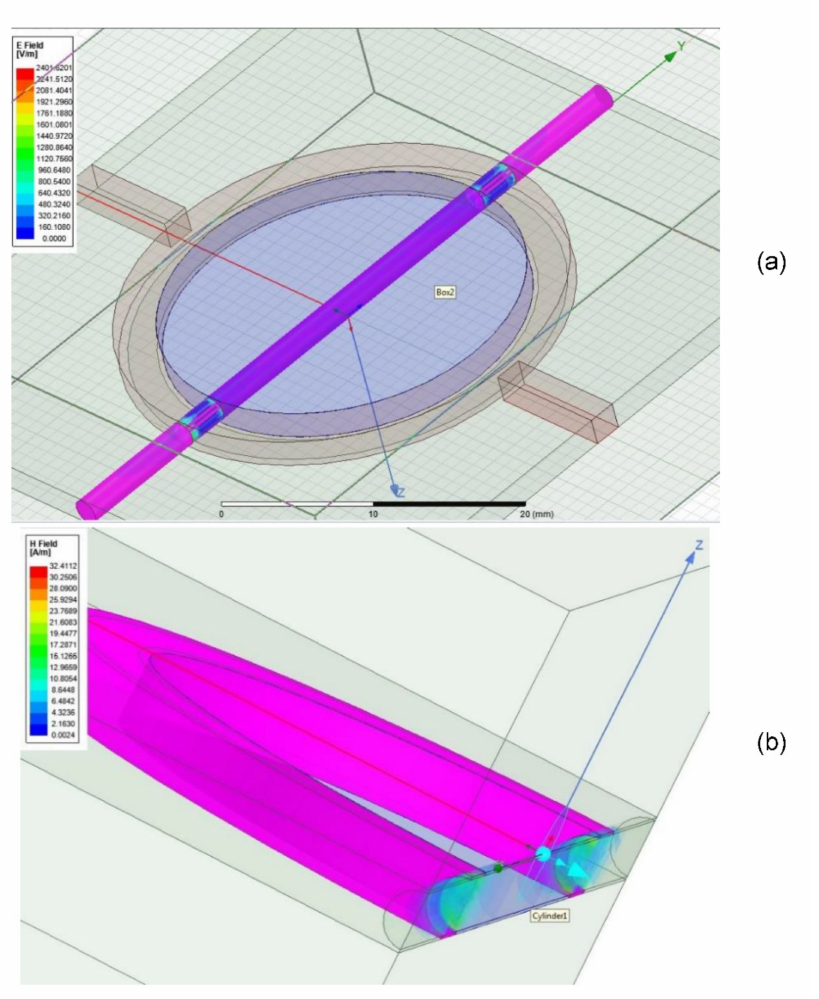
Figure 6. Microwave high-frequency simulation; ( a ) the transmission coefficient of the proposed microwave detector in the presence of the NH 3 at 400 ppm; ( b ) isometric view of the microwave resonator sensor with a glimpse of the electric field distribution at the occurrence of the resonance in the presence of NH 3 .